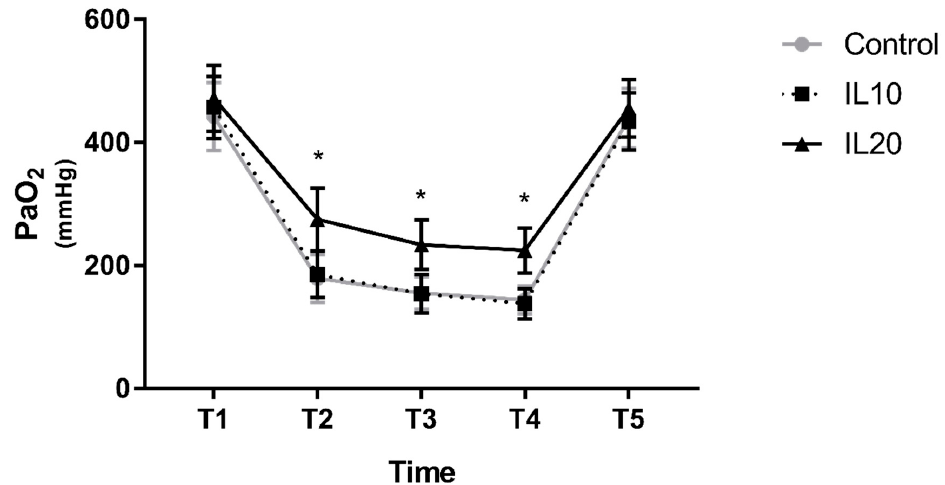
Figure 2. The PaO 2 . Error bars represent standard deviation. IL10, iloprost 10 µ g group; IL20, iloprost 20 µ g group; * indicates p < 0.0001 compared to the control group. T1, 15 min after changing the patient’s position to the lateral decubitus position with two-lung ventilation (TLV); T2, T3, T4, 10, 20, and 30 min after administration of iloprost in the lateral decubitus position with one-lung ventilation (OLV), respectively; and T5, 15 min after resuming TLV in the lateral decubitus position.